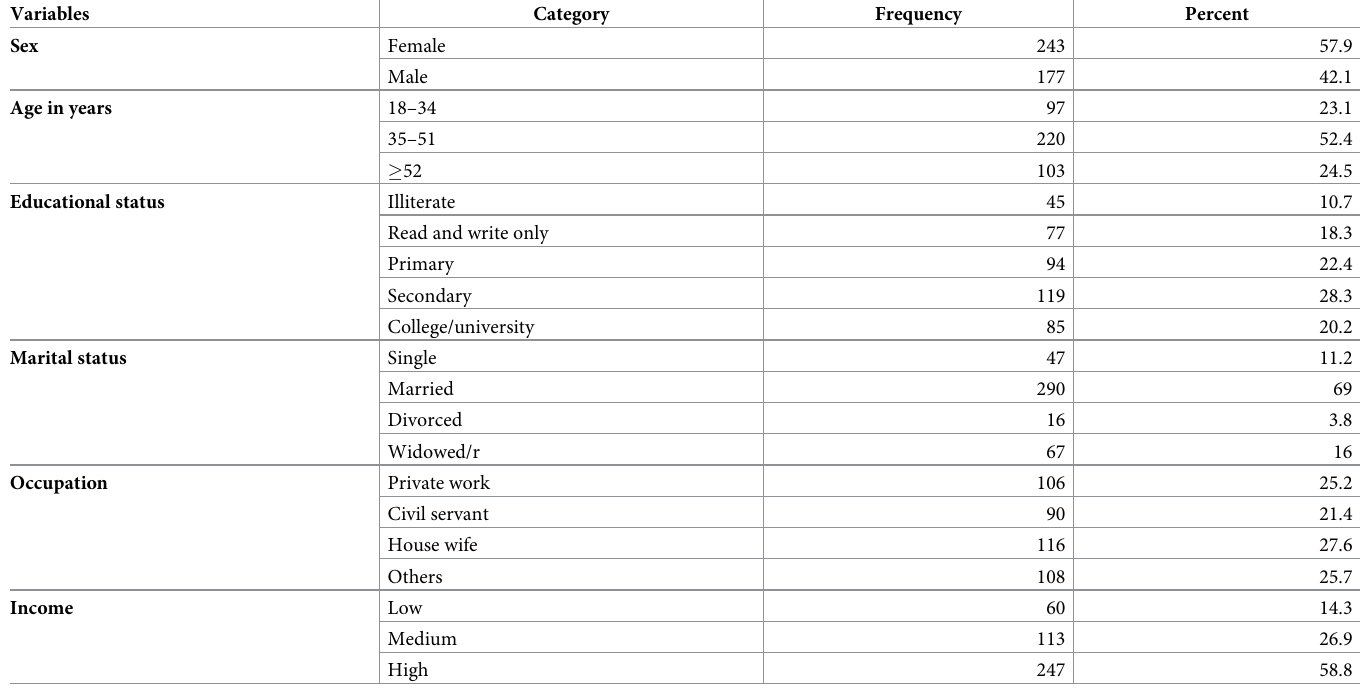
Table 1. Socio-demographic characteristics of study participants among adult cancer patients at the oncology clinic of TASH, Addis Ababa, Ethiopia, 2021.